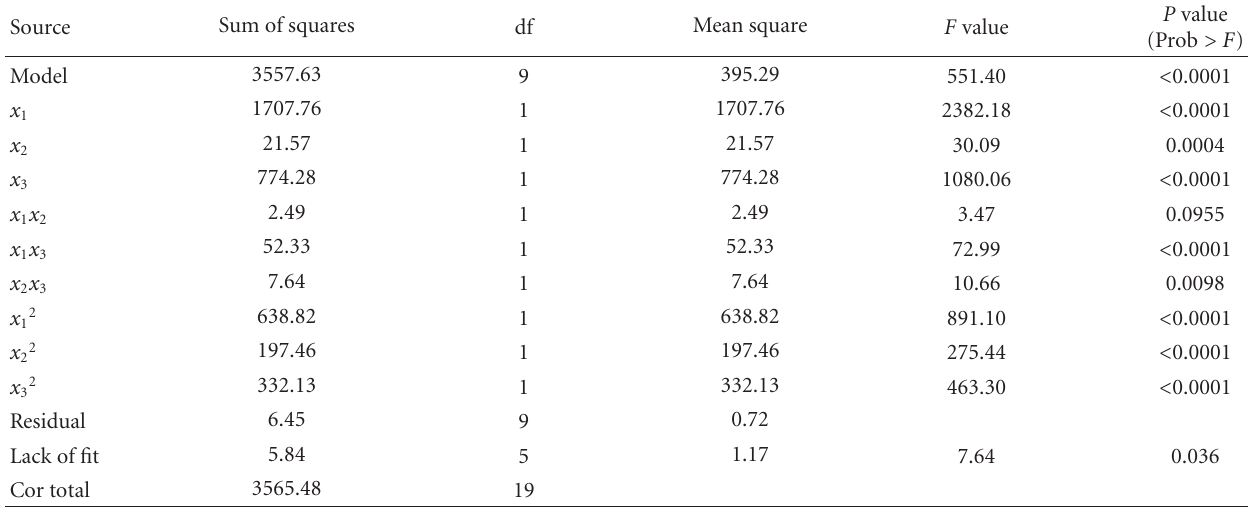
Table 3: Analysis of variance (ANOVA) for the model regression representing degradation